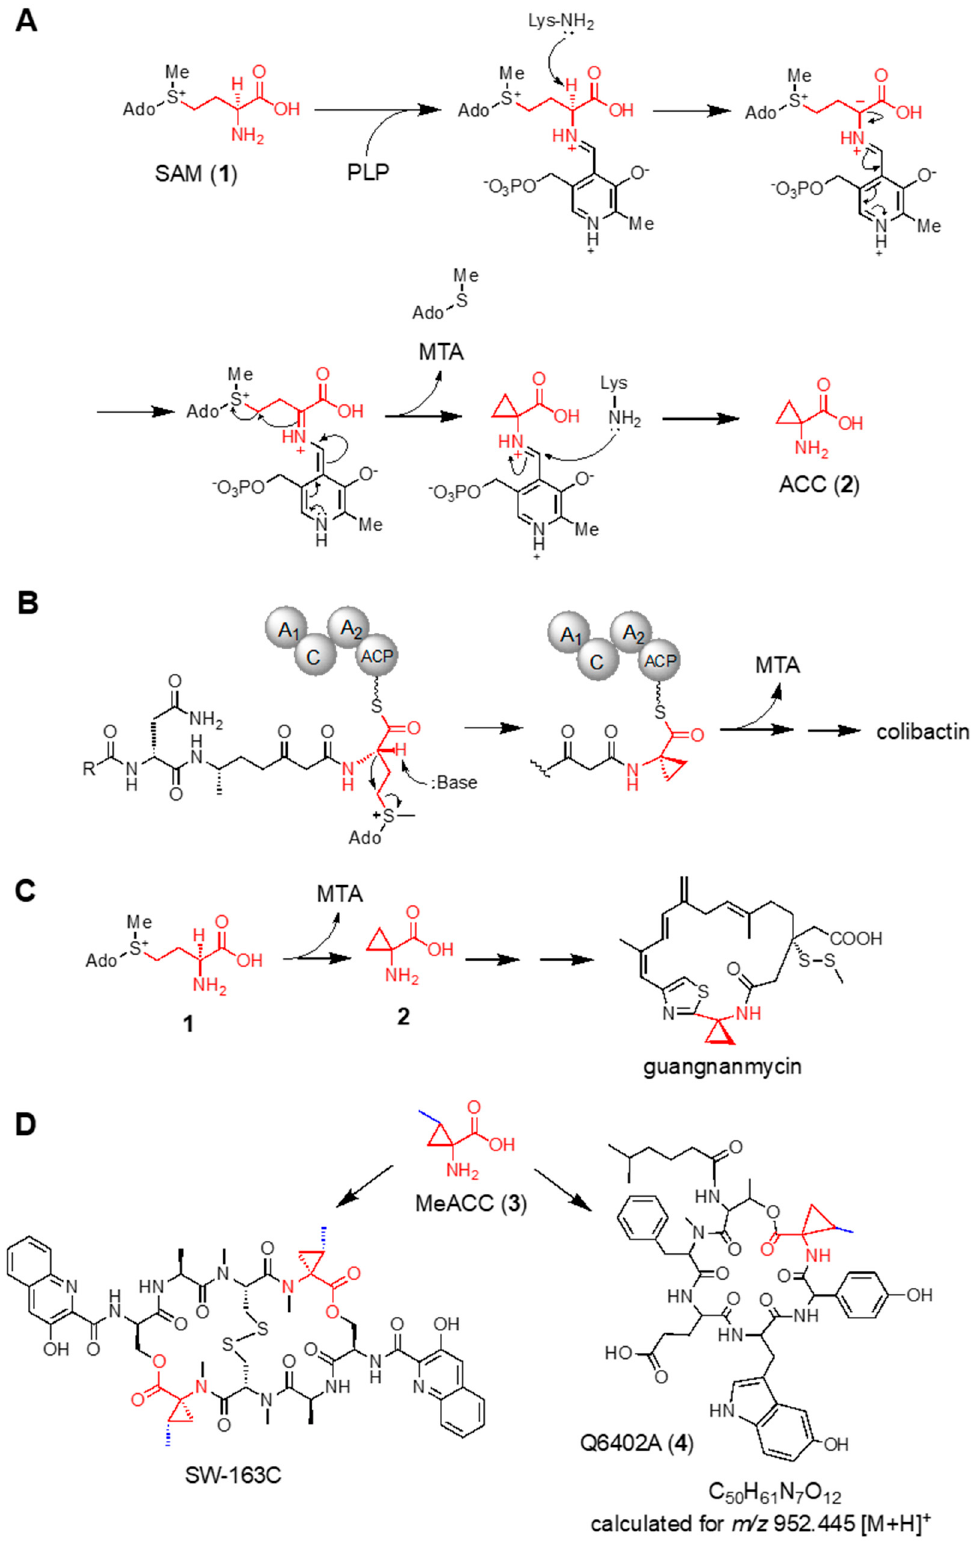
Figure 1. Chemical structures. ( A ) 1-aminocyclopropanecarboxylic acid (ACC) formation catalyzed by plant ACC synthases. ( B ) Formation of the ACC building block in the colibactin biosynthesis. ( C ) ACC formation catalyzed by GmnY in the guangnanmycin biosynthesis. ( D ) Peptide natural products with the 2-methyl-ACC (MeACC) building block.